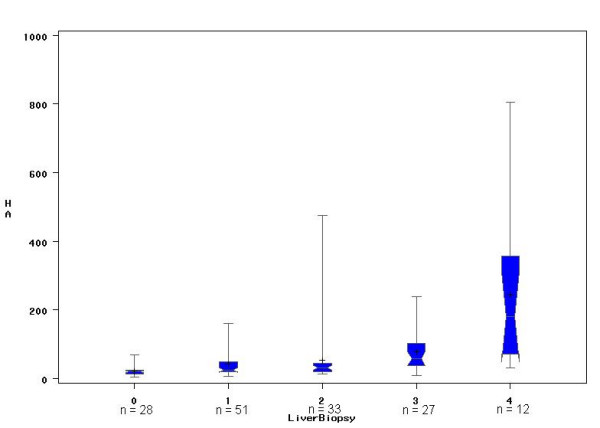
Box & Whisker plot representing the relation between the stage of fibrosis and HA level. The line through the box is the median; the top and bottom edges of each box represent the 25th and 75th percentiles, giving the interquartile range; and the cross in the box is the mean. The vertical lines at each side of the box represent distribution from the quartile to the farthest observation. The curve represents the HA median value of each fibrosis stage (F0: 20 μg/l, F1: 25 μg/l, F2: 30 μg/l, F3: 58 μg/l, and F4: 180 μg/l). The relation between the stages of fibrosis and HA level was statistically significant (Kruskal-Wallis – p < 0.0001). Spearman rank correlation coefficient (r) between the stage of fibrosis and HA level was 0.55.